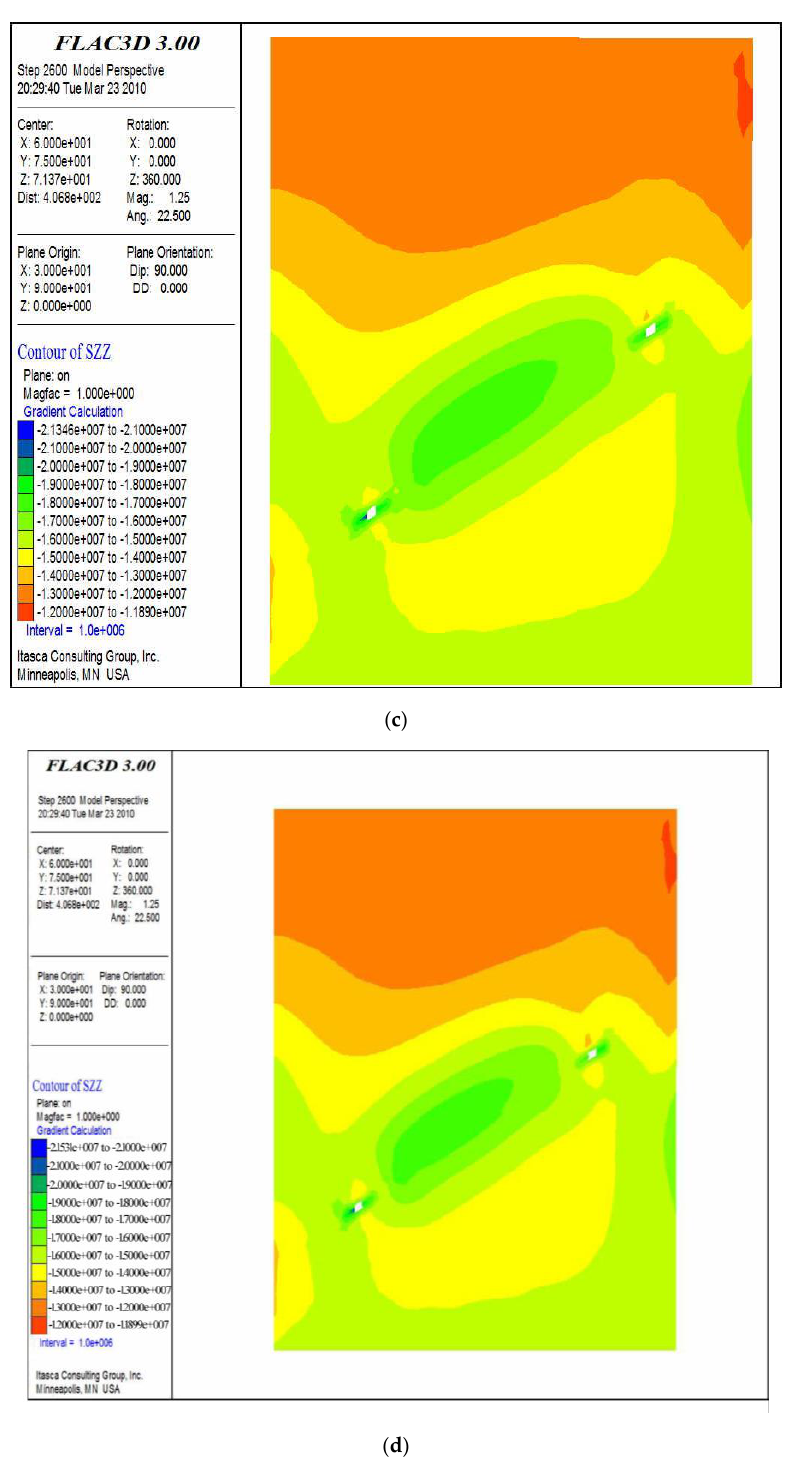
Figure 16. Vertical stress in coal seam after different water injection time: ( a ) 5 h; ( b ) 10 h; ( c ) 15 h and ( d ) 30 h.